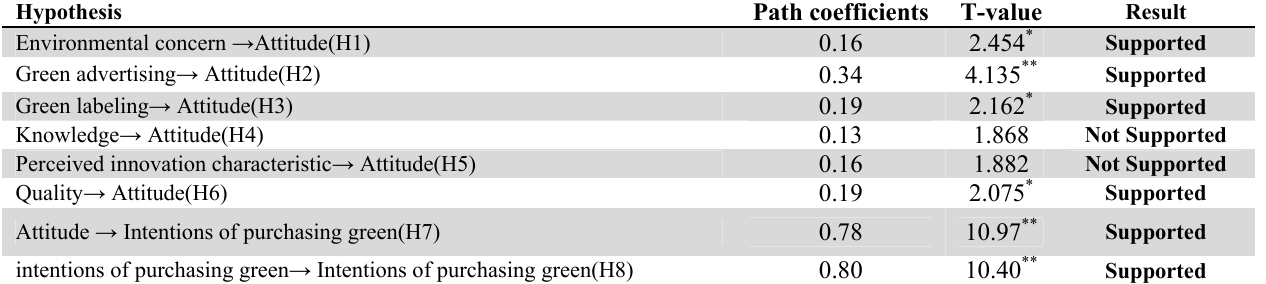
Path coefficients, t-value, Goodness of fit Statistics and